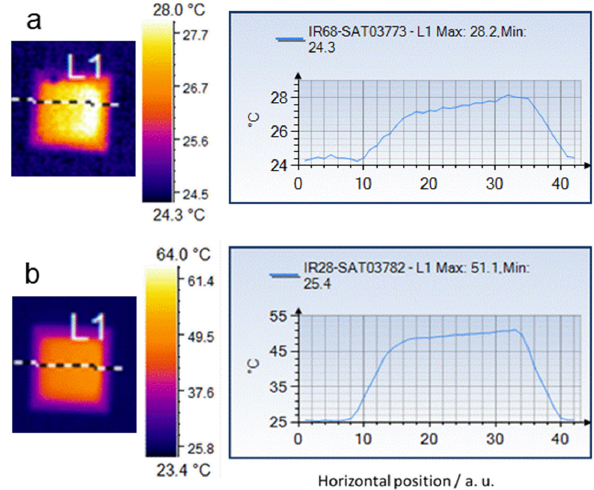
Figure 3. Thermal image acquired by the IR camera on ( a ) water and ( b ) the sample at 51 mg mL − 1 concentration at the intermediate power (8.7 W cm − 2 ) after 8 min of irradiation. The temperature measured at the cross-sectional L1 line (left) is recorded in the picture on the right. In this case, a maximal value of 28.2 °C and 51.1 °C was obtained for water and the sample, respectively. The laser beam went from right to left through the center of the wall of the cuvette.